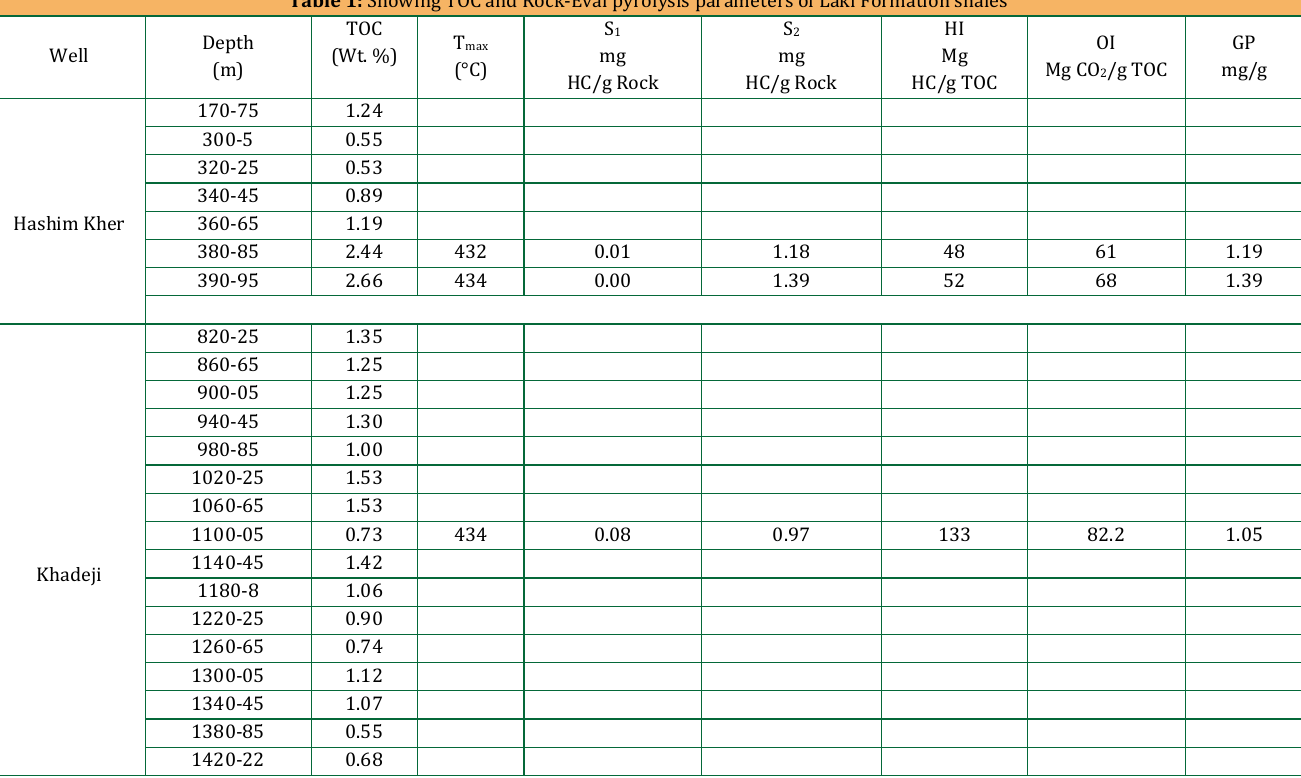
Table 1: Showing TOC and Rock-Eval pyrolysis parameters of Laki Formation shales